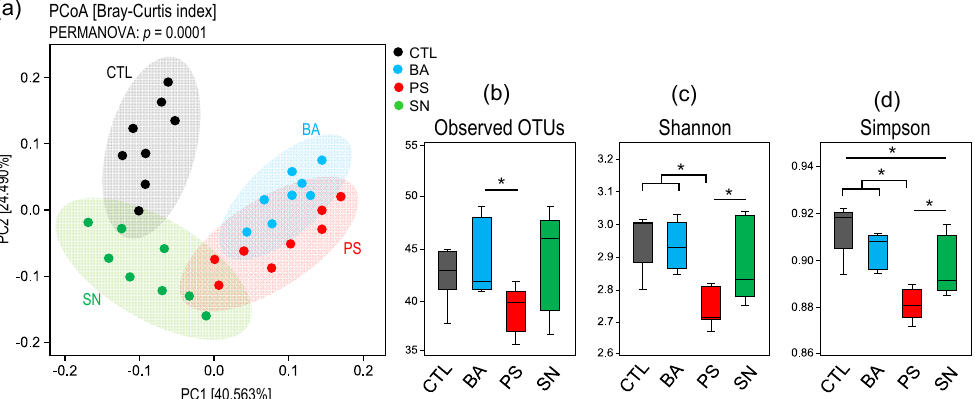
Figure 1. Distinct gut microbiome arrays in mice consuming different preservatives. ( a ) β -diversity (principal coordinate analysis; PCoA) and ( b – d ) α -diversity indices in mice consuming benzoate (BA), potassium sorbate (PS), or sodium nitrite (SN) versus control (CTL) mice. * p < 0.05.